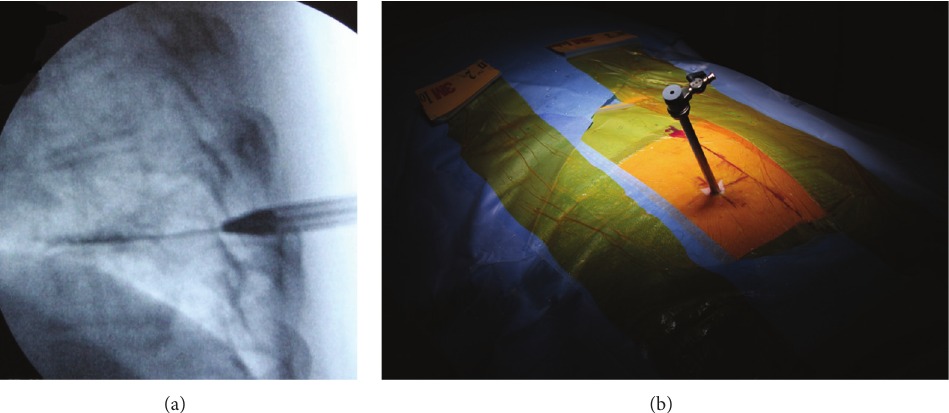
Figure 3: A sequential dilator was then inserted over the wire towards the posterolateral margin of the facet (a). A working cannula was guided to the extraforaminal region over the dilator (b).